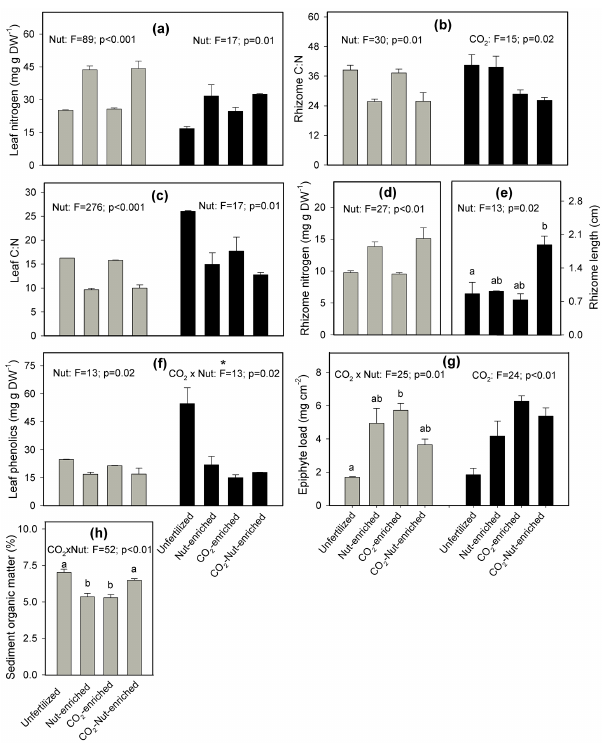
Figure 2. Effects of CO 2 and nutrient additions on Zostera noltii plant-, community-, and ecosystem-level traits measured at the end of the experiment from the low-nutrient (grey bars) and high- nutrient meadow (black bars). Bars are means ( ± SE, n = 2). The F statistics and p levels from two-way ANOVA tests are shown for each fixed crossed factor (CO 2 ; Nut: nutrients) or interaction (CO 2 × Nut). Lowercase letters above bars show significant dif- ferences between treatments for significant interactions (Welch’s t tests, see Methods). Only restrictive significant effects ( p <0.03) selected to minimize the possibility of Type I error due to unequal variances are shown here; the non-significant effects are shown in Sect. S4 (in the Supplement).